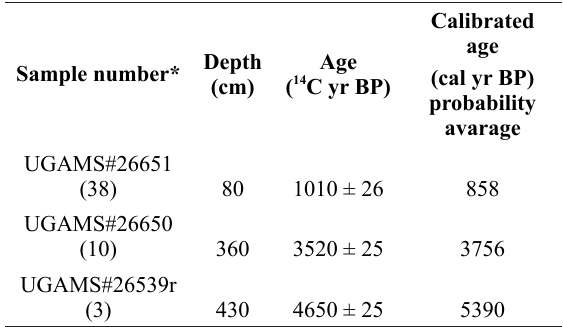
Radiocarbonic and calibrated ages of selected samples from the PCSC-3